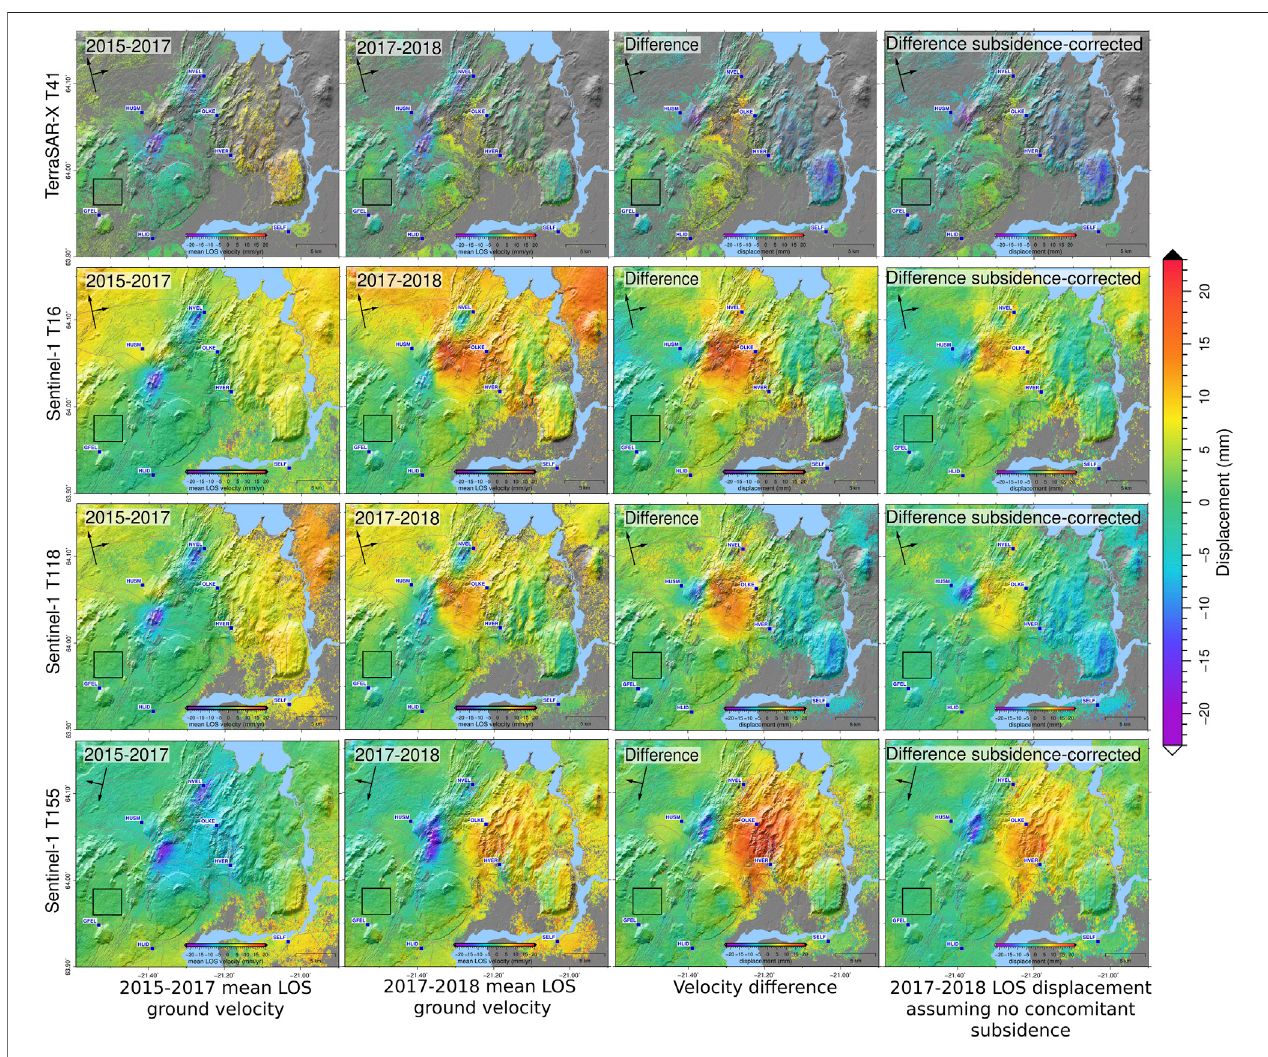
FIGURE 5| InSAR mean LOS velocitiesfor TerraSAR-X (TSX) track T41 and Sentinel-1 (S1) tracks T16, T118 and T155 ( Table 1 ) over the Hengill area, from left to right: 2015 – 2017, 2017 – 2018, velocity difference (subtracting signals observed in 2017 – 2018 from 2015 – 2017) and the last column shows the isolated LOS displacementoftheupliftperiod(calculatedfromtheLOSvelocity differenceassumingnosubsidenceconcomitanttothe2017 – 2018uplift,asexplainedinIsolatingand modelling the 2017 – 2018 uplift signal).